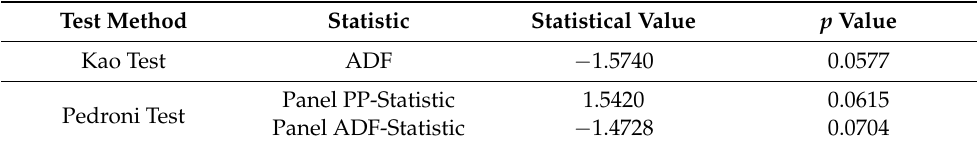
Table 8. Panel cointegration